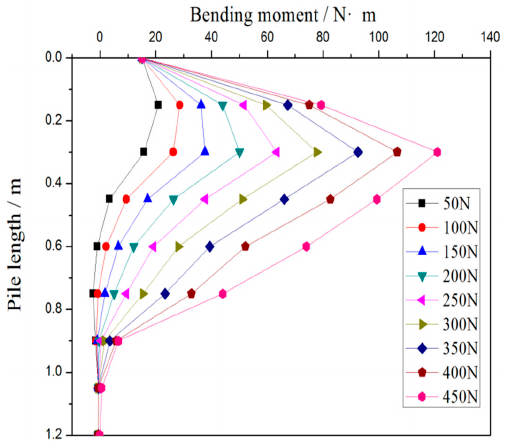
Figure 4. Pile bending moment under different loads.